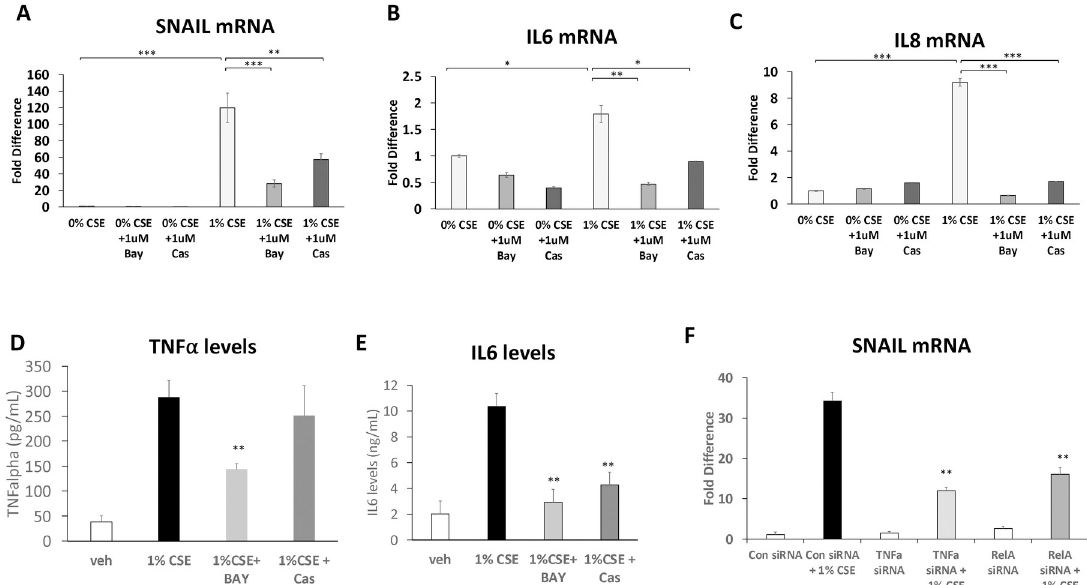
Fig 2. Inhibition of the TNF α -dependent NF- κ B pathway blocks SNAIL and inflammatory cytokine production in CSE exposed ARPE-19 cells. ARPE-19 cells exposed to CSE for 24 hours in the presence or absence of the NF- κ B inhibitor, BAY-11-7082 (BAY, 1 μ M) or the TNF α inhibitor, CAS 1049741 (CAS, 1 μ M). After exposure, total RNA was isolated and analyzed by qPCR. CSE exposed ARPE-19 cells produced elevated SNAIL (A), IL6 (B), and IL8 (C) mRNA. Fold differences were normalized to 0% CSE for each condition. (D) TNF α and (E) IL-6 production from culture supernatants from cells treated as above were analyzed by ELISA. CSE exposure increased both TNF α and IL-6. Inhibition of NF- κ B with BAY decreased TNF α production in ARPE-19 cells cultured with CSE while CAS did not. Both BAY and CAS significantly decreased IL-6 production. (F) APRE-19 cells were treated with control, TNF α or RELA siRNA for 24 hours. After treatment with siRNA, cells were exposed, or not, to 1.0% CSE for 24 hours. After exposure, cells were harvested and RNA levels were analyzed by qPCR. SNAIL mRNA levels were significantly increase by CSE exposure in control siRNA treated cells while SNAIL mRNA production was significantly attenuated in cells cultured with TNF α or RELA siRNA. Error bars represent standard error of data set. N � 3 for each. � p < 0.05, �� p < 0.01, ��� p <